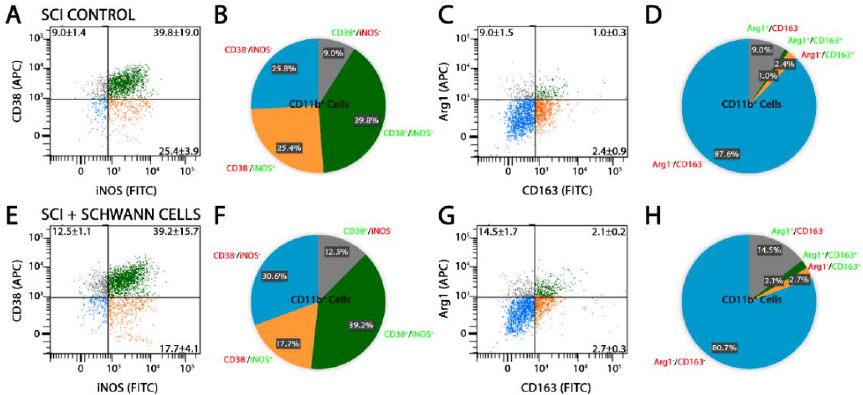
Figure 4. CD11b immune cells expressing a highly pro-inflammatory CD38 + iNOS + phenotype or anti-inflammatory Arg1 + CD163 + form after SCI were unaltered by SC transplantation. Representative images of flow cytometry analysis and pie charts of CD11b population dynamics at 14 days post-injury (7 days post-transplantation) reveal that CD11b immune cells with a highly pro-inflammatory CD38 + iNOS + phenotype after SCI ( A , B ) are not altered by SC transplantation ( E , F ). Similarly, CD11b immune cells with a highly anti-inflammatory Arg1 + CD163 + phenotype were unchanged across SCI controls ( C , D ) and SC-transplanted groups ( G , H ). Results are expressed as mean ± SD. For panels ( A , B ), the blue dots represent the CD11b population that were CD38 − iNOS − , the orange dots represent the CD11b population that were CD38 − iNOS + , the gray dots represent the CD11b population that were CD38 + iNOS − and the green dots represent the CD11b population that were double positive for both CD38 + iNOS + . For panels ( C , D ), the configuration for the colored dots is the same for the representation labeling, single, double or absent, though the proteins Arg1 and CD163 are represented rather than CD38 and iNOS.